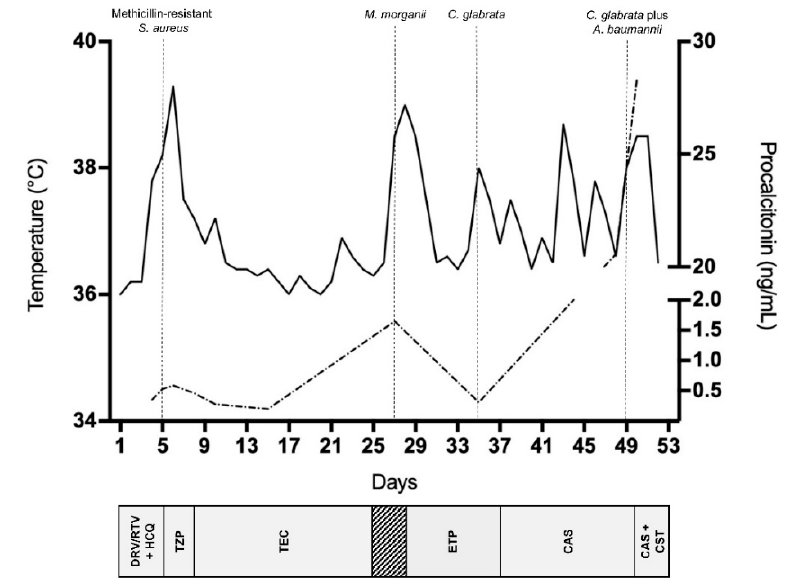
Figure 2. Timeline of major microbiological events during the patient’s clinical course and relative antimicrobial treatments. Fever (solid line) or procalcitonin (dashed line) patterns are shown. DRV / RTV, darunavir / ritonavir; HCQ, hydroxychloroquine; TZP; piperacillin / tazobactam; TEC, teicoplanin; ETP, ertapenem; CAS, caspofungin; CST,